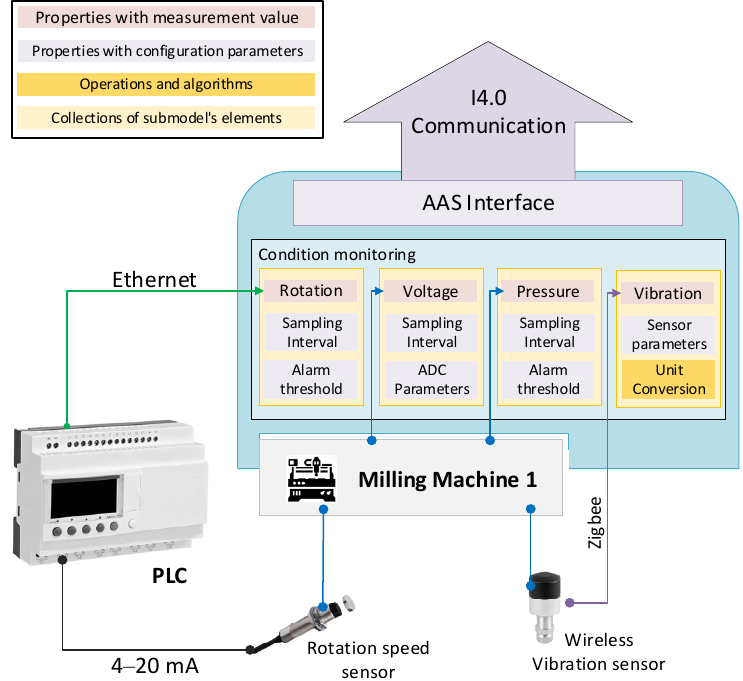
Figure 5. The structure of the AAS of a milling machine. The submodel “Condition Monitoring” provides measurement value, configuration parameters, alarms and operations in a uniform manner by means of the AAS interface. All the implementation details and underling technologies adopted for data collection and manipulation are hidden by the AAS.